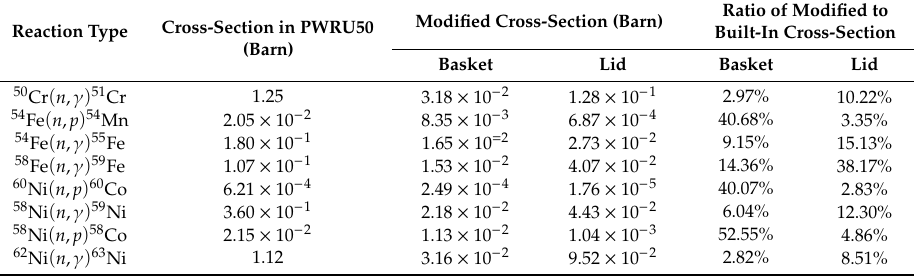
Table 6. Comparison of built-in cross-section library in ORIGEN-2 and modified e ff ective microscopic cross-section calculated in this